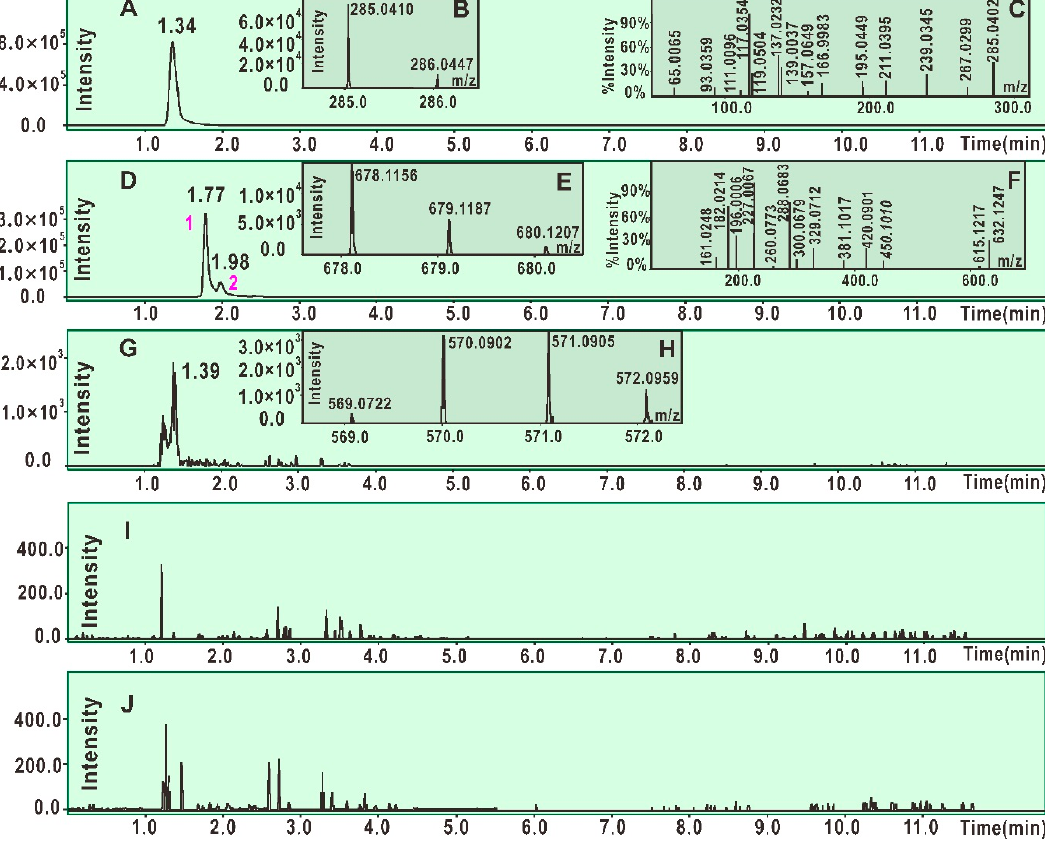
Figure 2. Main results of UPLC-ESI-Q-TOF-MS/MS analysis. ( A ) Chromatogram of scutellarein when the formula [C 15 H 10 O 6- H] − was extracted; ( B ) primary MS spectra of scutellarein. ( C ) Secondary MS spectra of scutellarein; ( D ) chromatogram of the radical adduct formation (RAF) product, scutellarein-DPPH, when the formula [C 33 H 21 N 5 O 12 -H] − was extracted; ( E ) primary MS spectra of the RAF product scutellarein-DPPH (from peak 1 and peak 2); ( F ) secondary MS spectra of the RAF product scutellarein-DPPH (from peak 1); ( G ) chromatogram of possible dimeric products of scutellarein when the formula [C 30 H 18 O 12 -H] − was extracted; ( H ) primary MS spectra of possible dimeric products of scutellarein; ( I ) chromatogram of the RAF product scutellarin-DPPH when the formula [C 39 H 29 N 5 O 18- H] − was extracted; ( J ) chromatogram of possible dimeric products of scutellarin when the formula [C 42 H 34 O 24 -H] − was